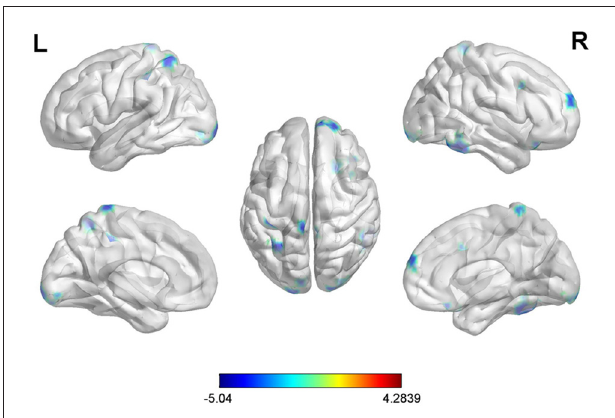
FIGURE 4 | Differences in right middle occipital gyrus (MOG.R) based FC between early postmenopausal women and controls (the peak level threshold was set at p = 0.001; cluster level FDR-corrected p < 0.05 or Small-volume corrected, FWE-corrected at p < 0.05 with a cluster size threshold of 20 contiguous voxels). All the FC strengths were decreased and marked in blue.